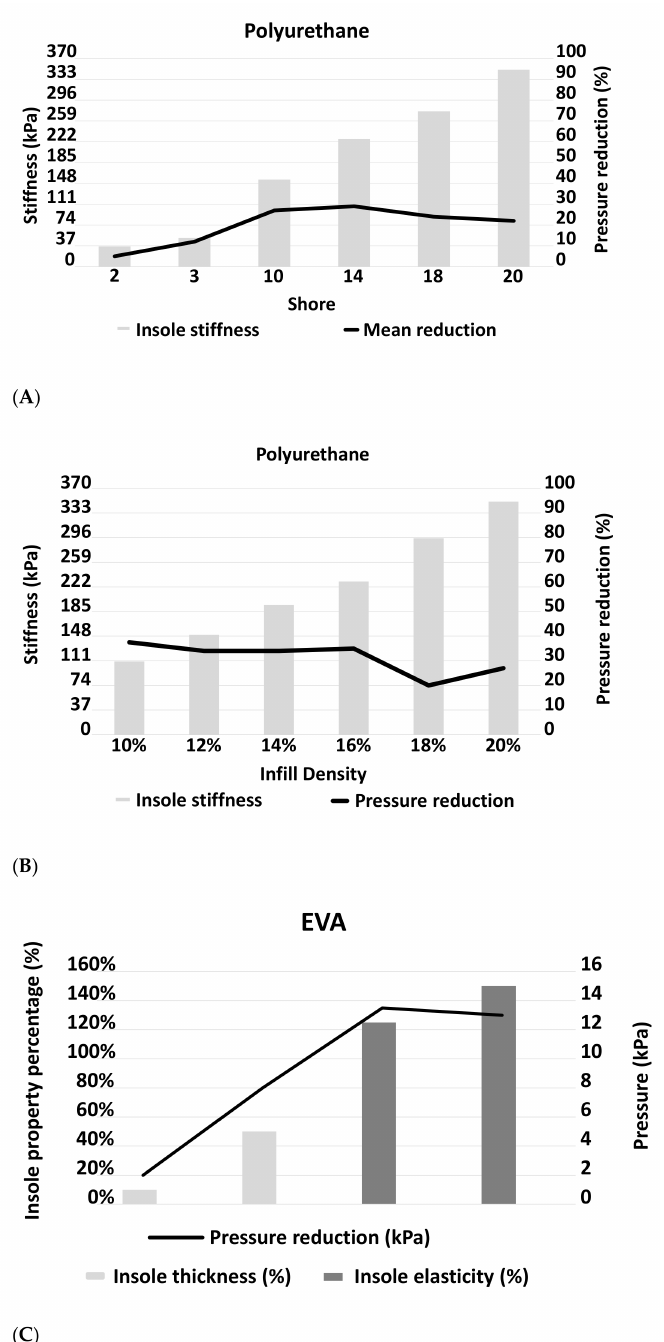
Figure 5. Pressure reduction in different insole material properties: ( A ) PU foam, ( B ) 3D-printed thermoplastic PU, and ( C ) EVA. PU, polyurethane; 3D, three dimensions; EVA, ethylene–vinyl